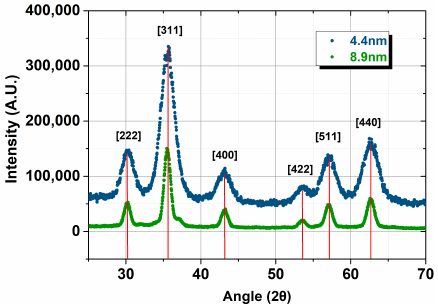
Figure 2. XRD patterns of the 4.4 nm and 8.9 nm samples (powders with oleic acid).